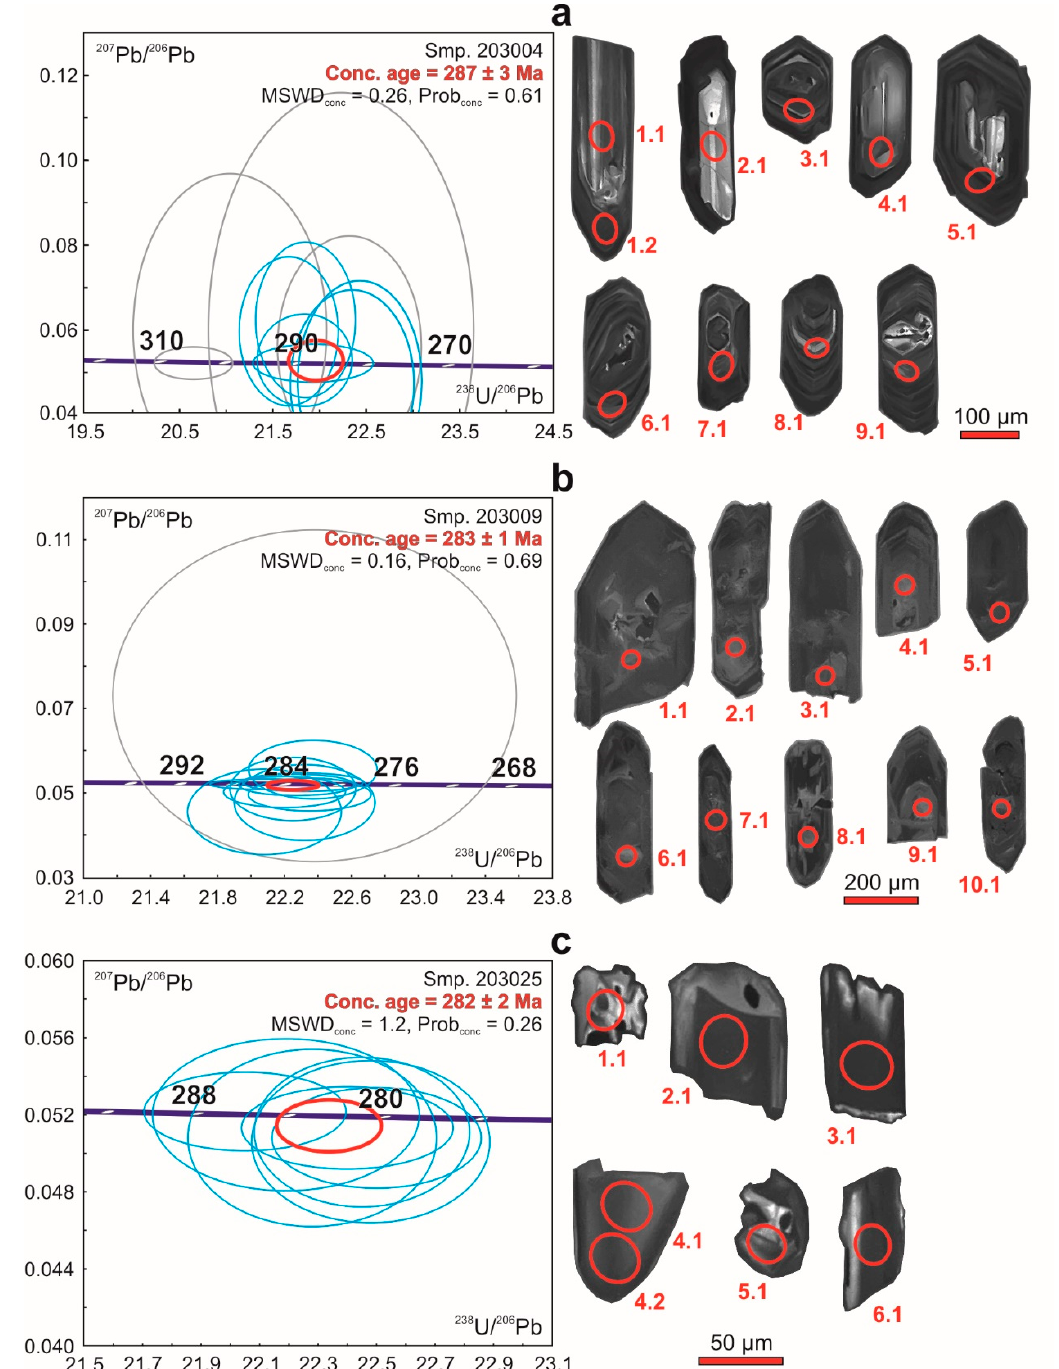
Figure 14. Concordia diagrams and CL zircon images for samples of the second generation of syncollisional granitoids of the Kara orogen: sample 203004 ( a ), sample 203009 ( b ), sample 203025 ( c ). Data-point error ellipses are 2s; decay-const. errs included.